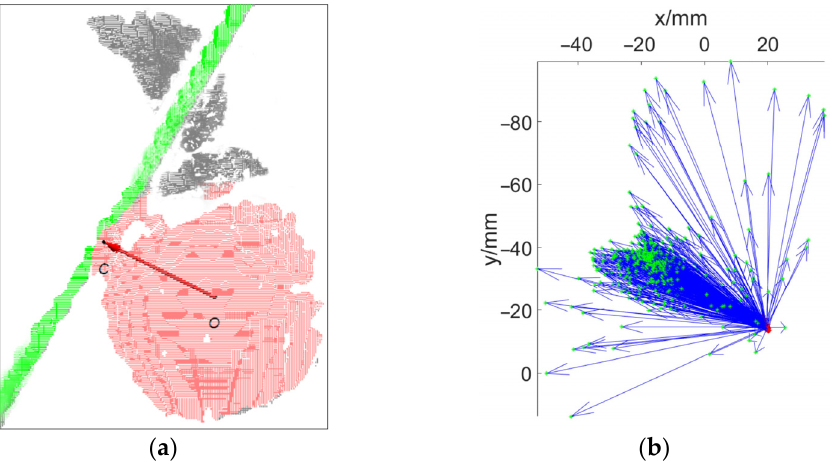
Figure 13. Distribution of apple orientation determinations for 474 experiments: ( a ) average of all results; ( b ) distribution of all calculated vectors OC .